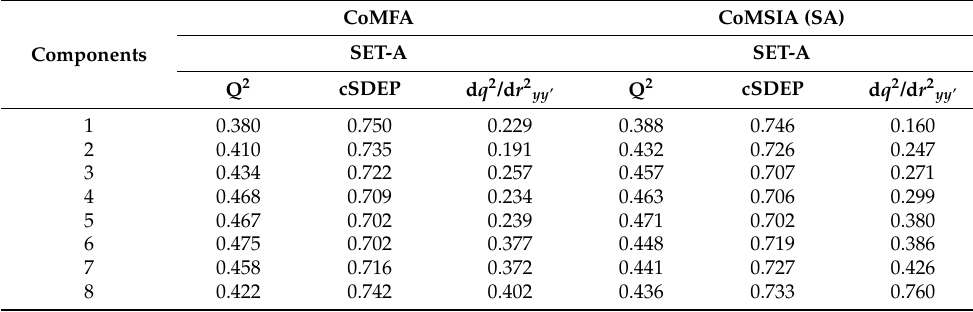
Table 11. Progressive scrambling results from the CoMFA and CoMSIA of PI3K δ